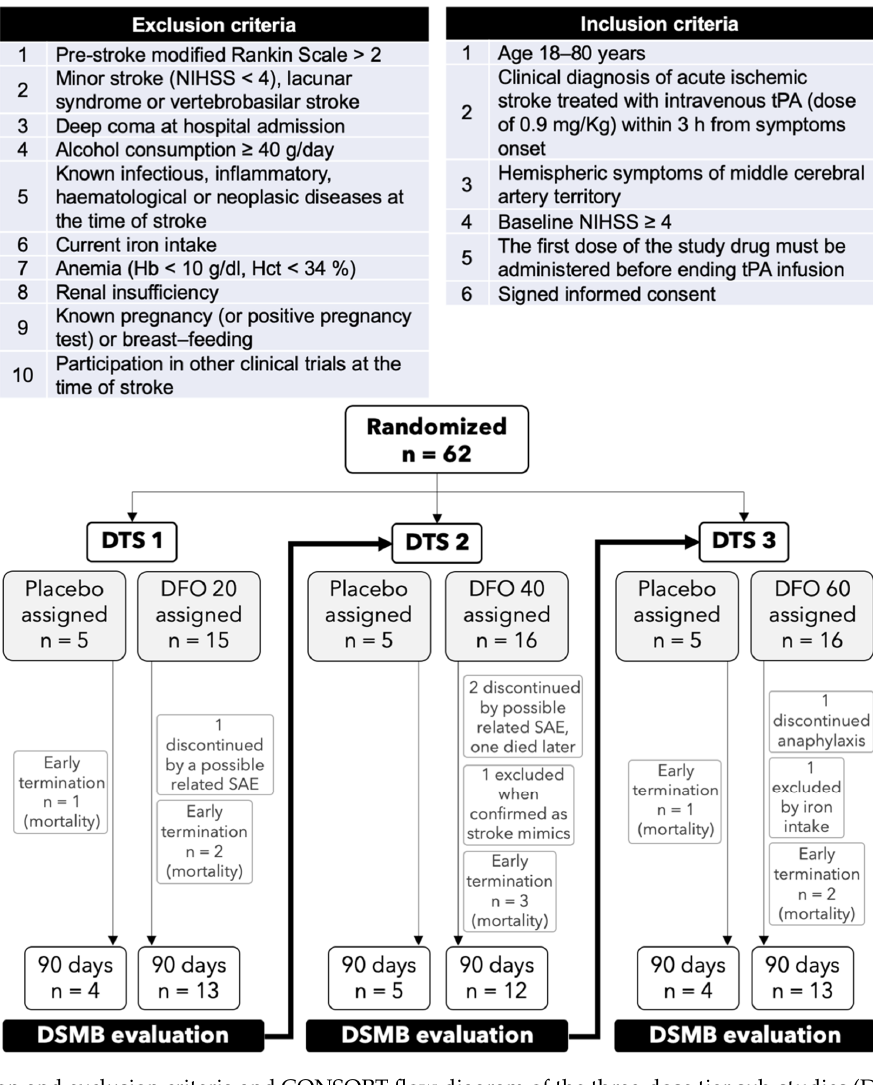
Figure 1. Inclusion and exclusion criteria and CONSORT flow diagram of the three-dose tier sub-studies (DTS). In each DTS early termination cases due to mortality, discontinuation due to serious adverse events (SAE) possibly related to treatment, and patients excluded are indicated.